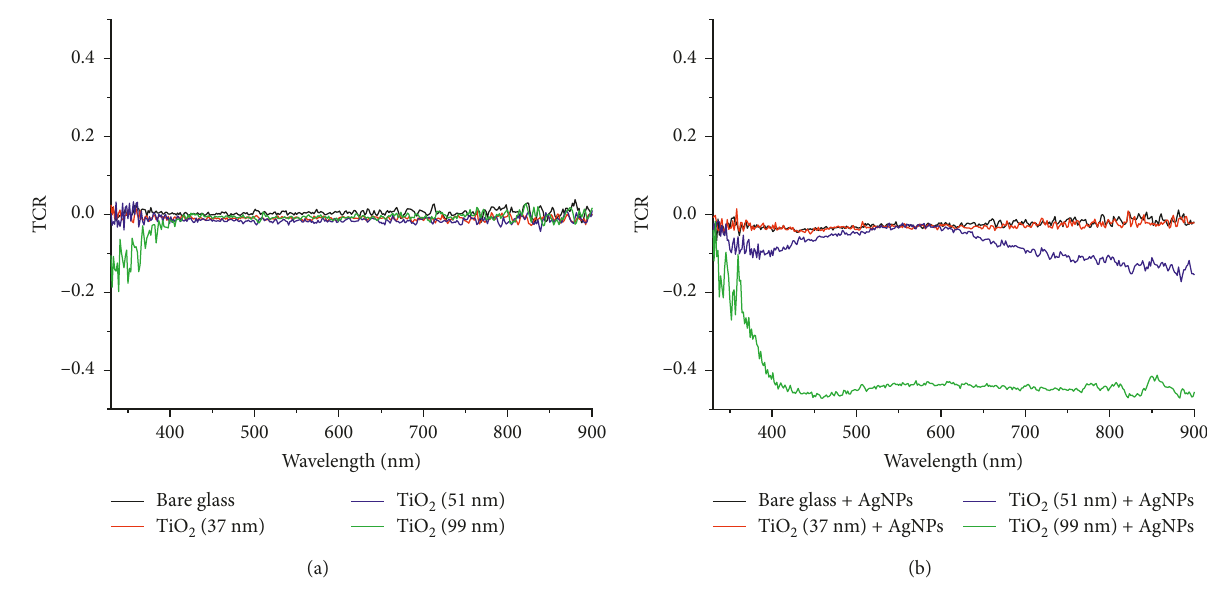
Figure 12: TCR of TiO 2 thin films without (a) and with AgNPs